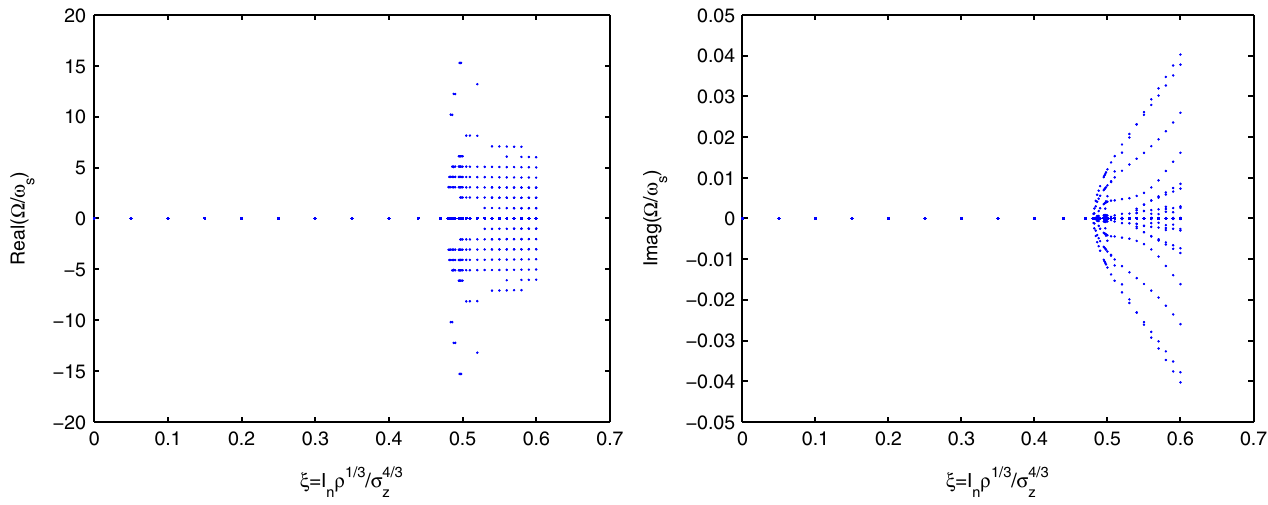
FIG. 6. Real parts (left) and imaginary parts (right) of all unstable modes driven by CSR in free space. Each dot represents an unstable mode.